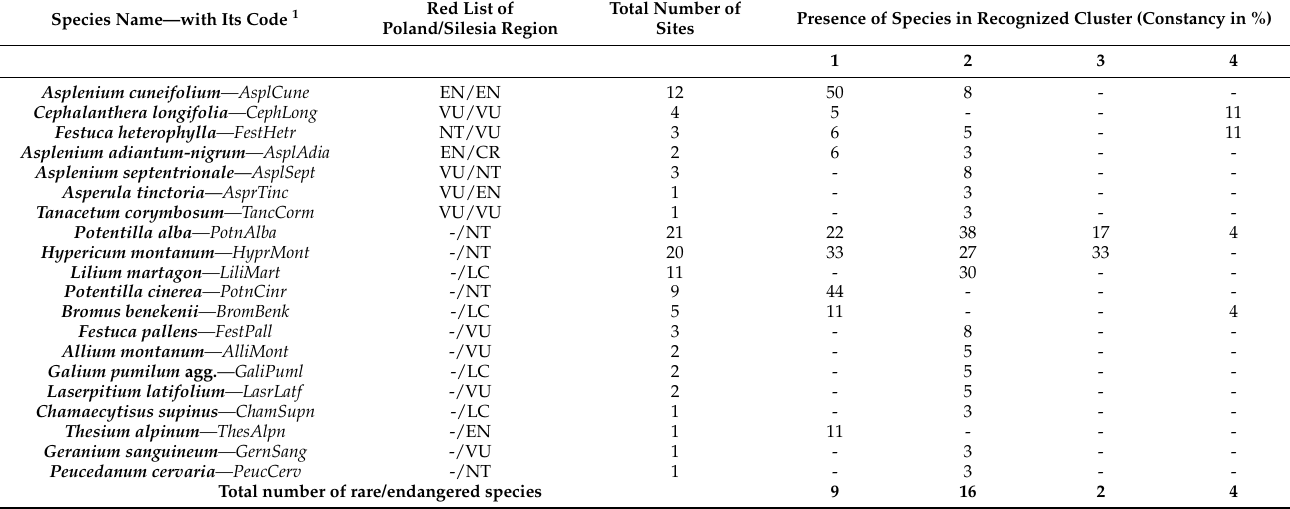
Table 2. The list of rare and endangered species occurring within the study area, along with the extinction risk category based on the Red Lists of Plants for Poland [48] and Lower Silesia [49], as well as the confirmed number of sites in Lower Silesian serpentine